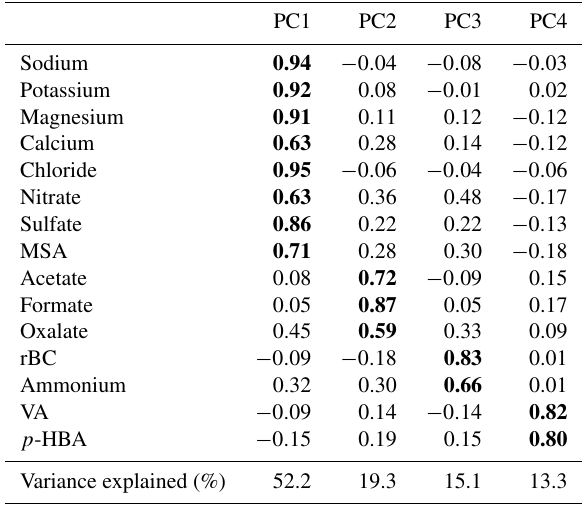
Table 2. Results of the principal component analysis (PCA) for the LF-09 preindustrial record (1222–1859) after VARIMAX rotation. Data are log-transformed annual averages. Values above 0.5 are in bold. MSA: methanesulfonate (CH 3 SO − 3